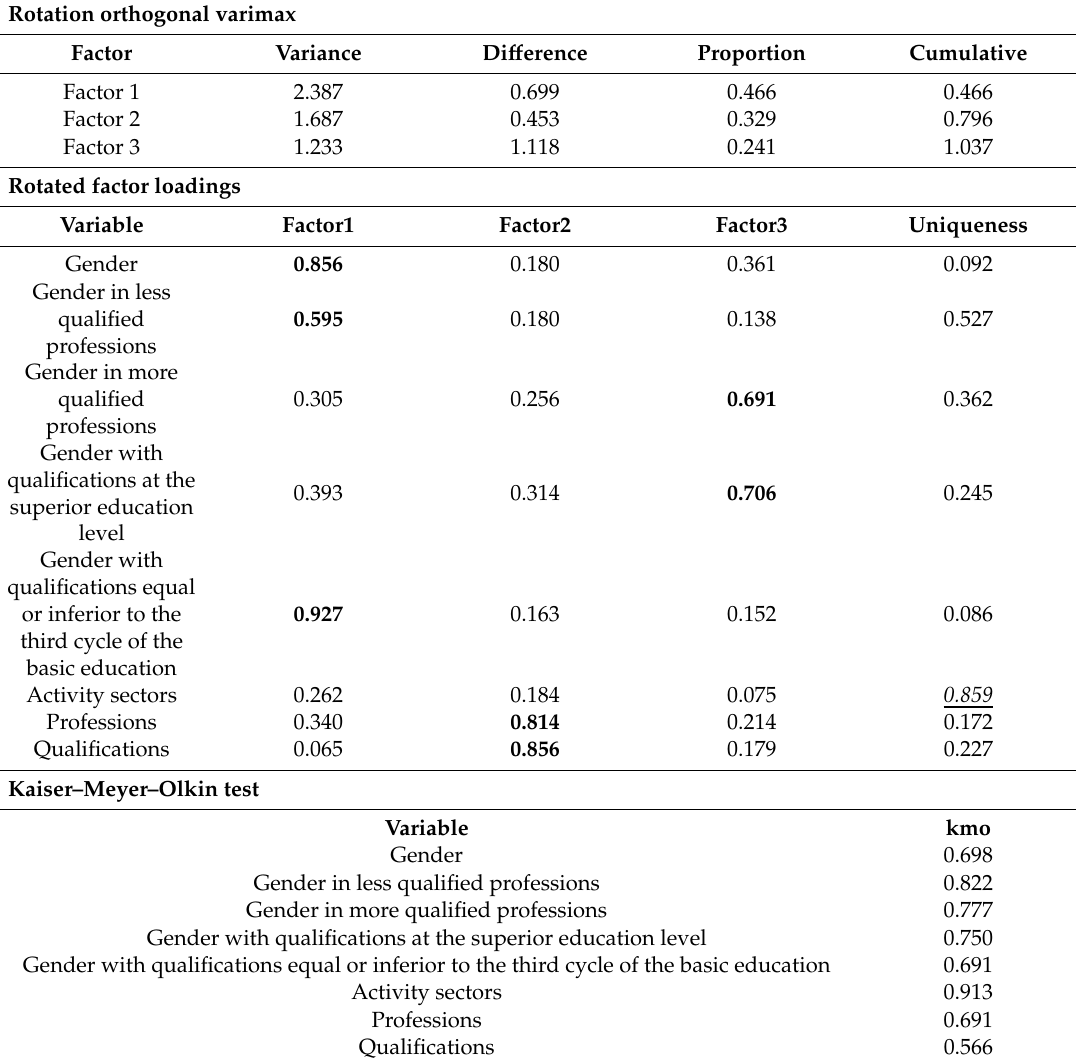
Table 1. Factor analysis for the disparities (%) in the monthly average earnings per employee, considering di ff erent